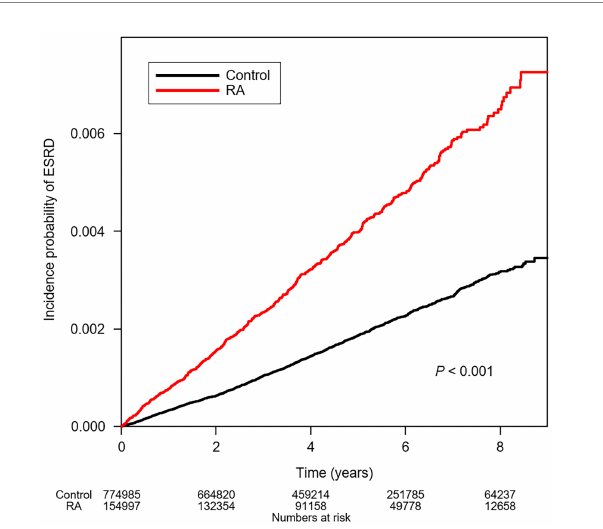
FIGURE 2 Kaplan–Meier curve for cumulative incidence of ESRD by RA. p